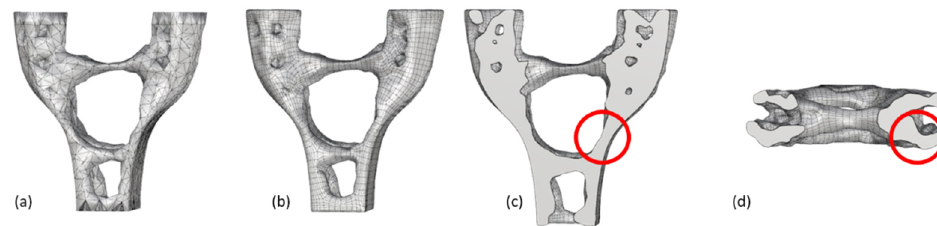
Figure 15. ( a ) tetrahedron-surface-mesh of the generated geometry ( b ) quad-mesh of the geometry ( c ) vertical section through the node, ( d ) horizontal section through the node. The calculation was performed with the additional condition of minimum thickness of 12.5 mm.